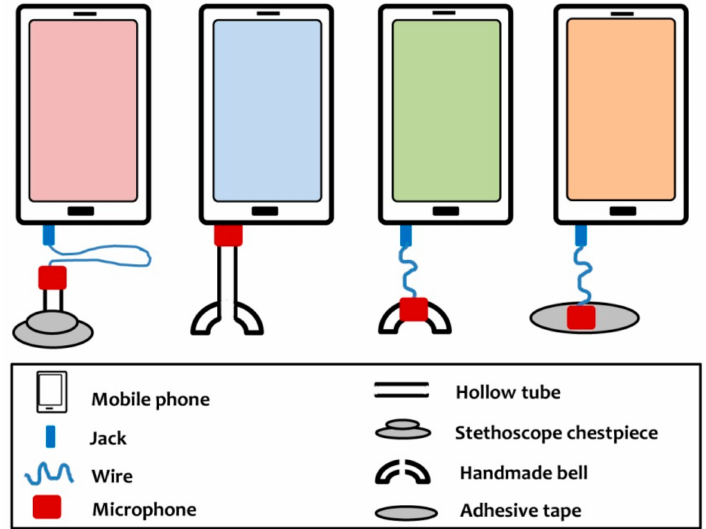
Figure 1. Types of low-cost, mobile phone-assisted, wired